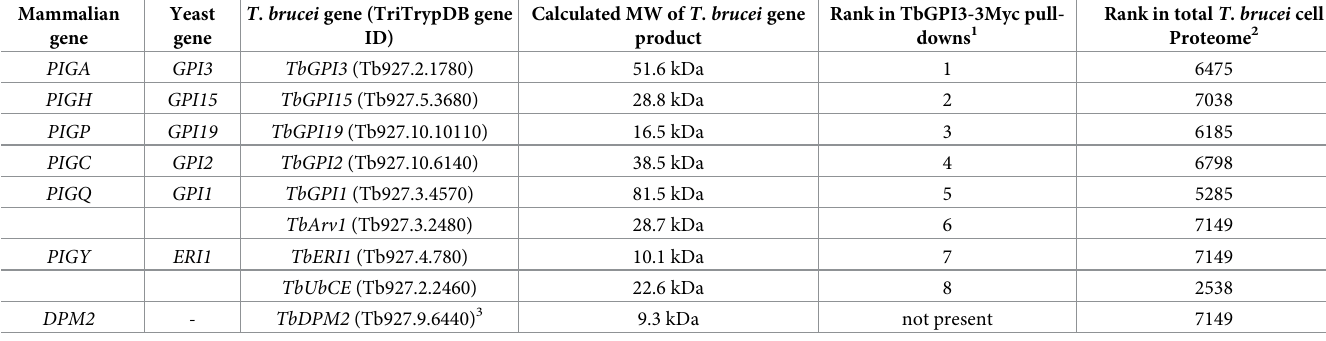
Table 1. Genes encoding UDP-GlcNAc: PI α 1–6 GlcNAc-transferase (GPI GnT) complex subunits in mammalian cells, yeast and T . brucei . Mammalian